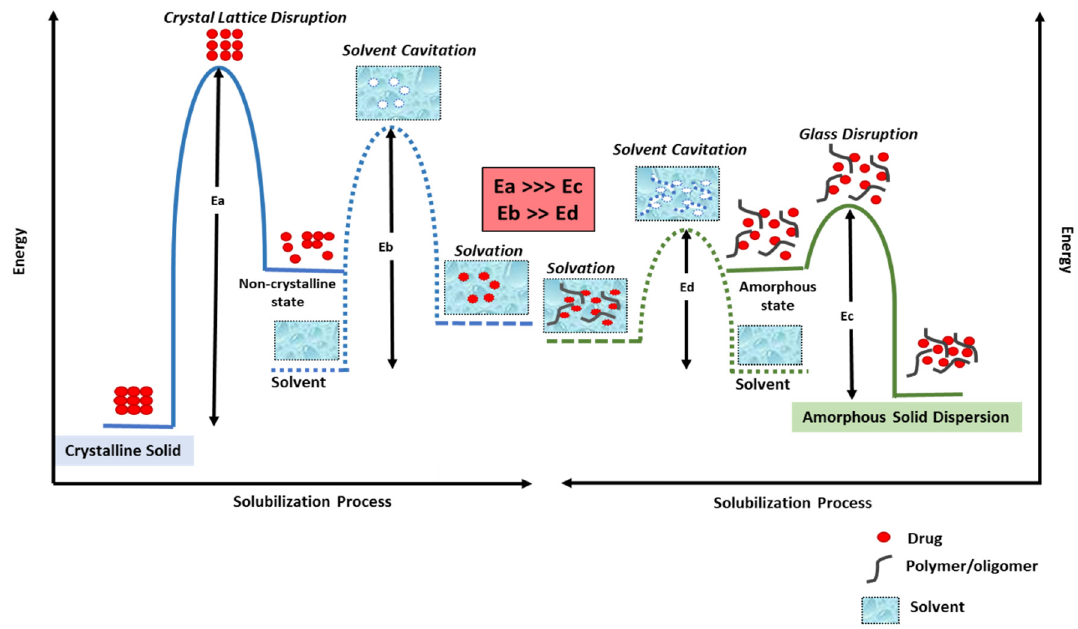
Figure 2. Activation energy diagram for the solubilization of a drug from a crystalline form (right) and from an ASD (left). (E a is the energy required to disrupt crystalline lattice of a drug in a conventional formulation; E c is the energy required to disrupt the glass solution of a drug in an ASD formulation, E b is the energy required for solvent cavitation in the solubilization of a crystalline solid and E d is the energy required for solvent cavitation in the case of ASD solubilization.).